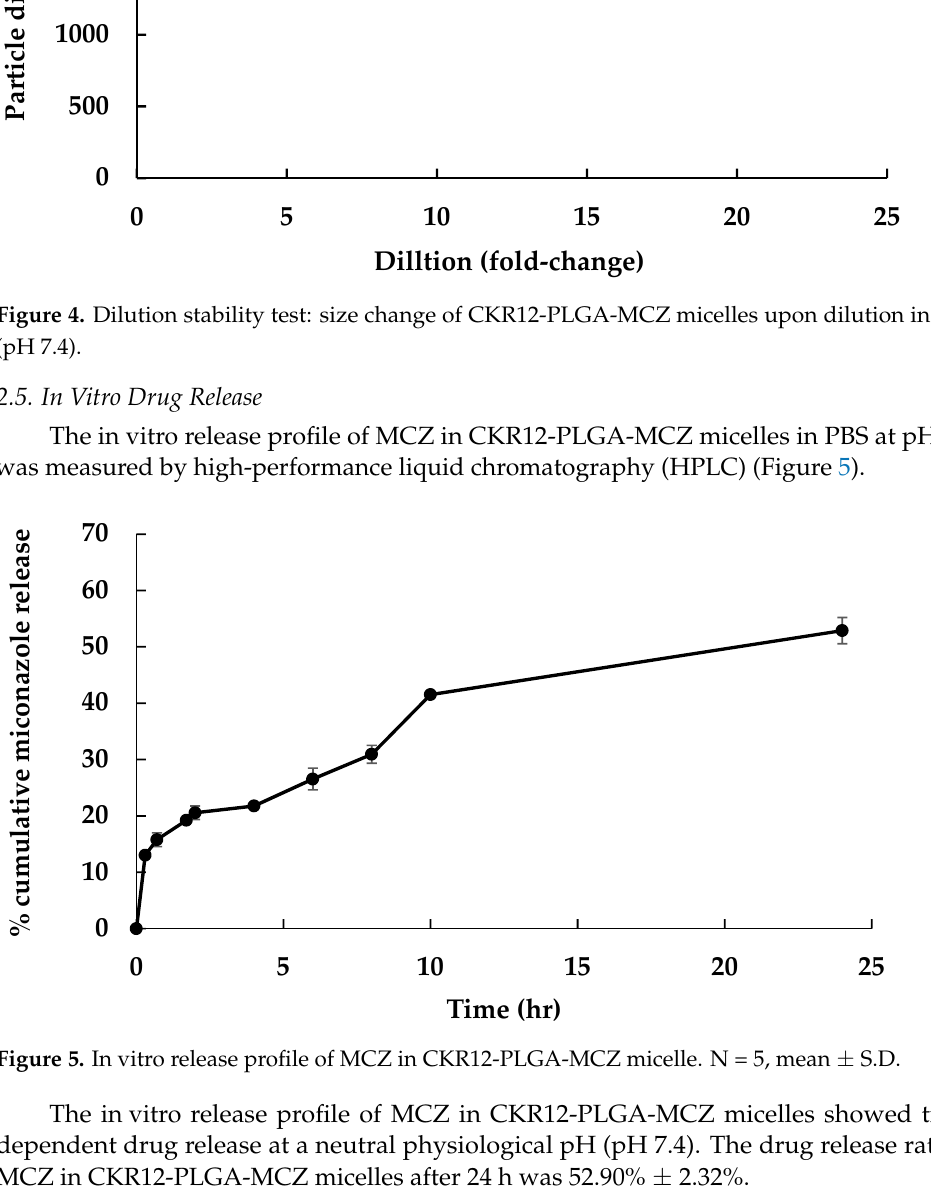
Figure 5. In vitro release profile of MCZ in CKR12-PLGA-MCZ micelle. N = 5, mean ± S.D. The in vitro release profile of MCZ in CKR12-PLGA-MCZ micelles showed time- dependent drug release at a neutral physiological pH (pH 7.4). The drug release rate of MCZ in CKR12-PLGA-MCZ micelles after 24 h was 52.90% ± 2.32%.